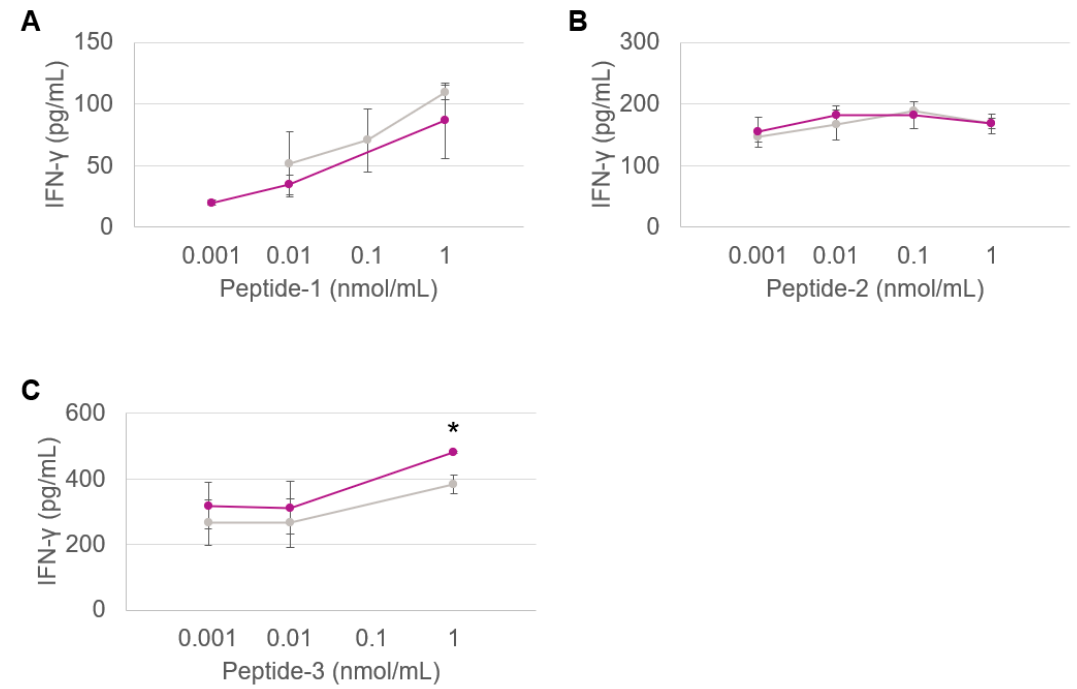
Figure 2. CD8+ T-cell response against peptide 1 presented by HLA-B7 ( A ), CD4+ T-cell response against peptide 2 presented by HLA-DRB1 ( B ) and CD8+ T-cell response against peptide 3 presented by HLA-A2 ( C ) contained in the PLGA nanovaccine formulations obtained via the inline (purple) and probe (grey) sonication methods. Each dot represents the mean value of triplicate wells. Assays are performed with three different nanoparticle batches. (*) Significant p < 0.05.